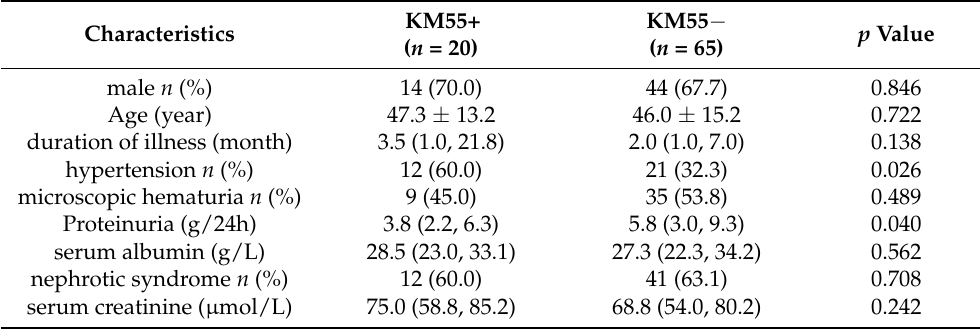
Table 4. Demographics and clinical features in PMN/IgAN patients based on the staining of glomeru- lar